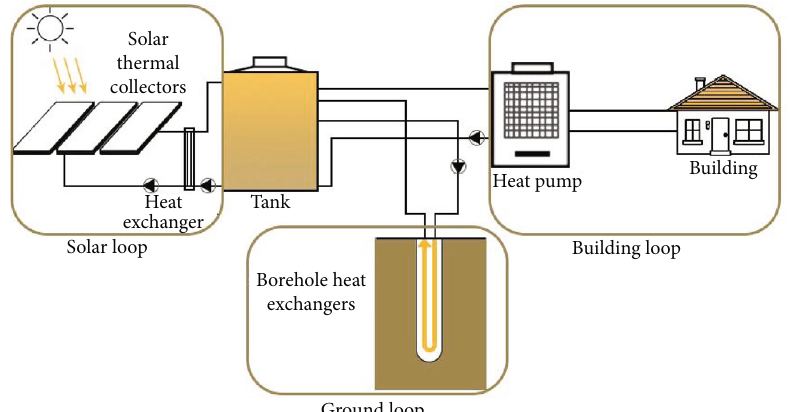
Figure 6: Proposed system involving GSHP and solar thermal